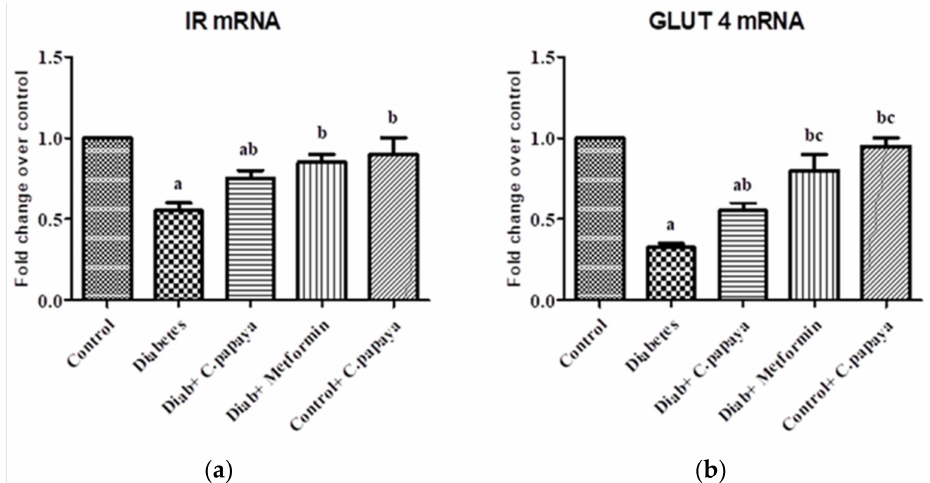
Figure 8. This figure represents the outcome of the ethanolic extract of C. papaya on IR ( a ) and GLUT4 ( b ) mRNA expression in the skeletal muscle of the control and diabetic rats. Each bar indicates the mean ± SEM of eight rats, with p < 0.05 indicating significant differences between the groups as: